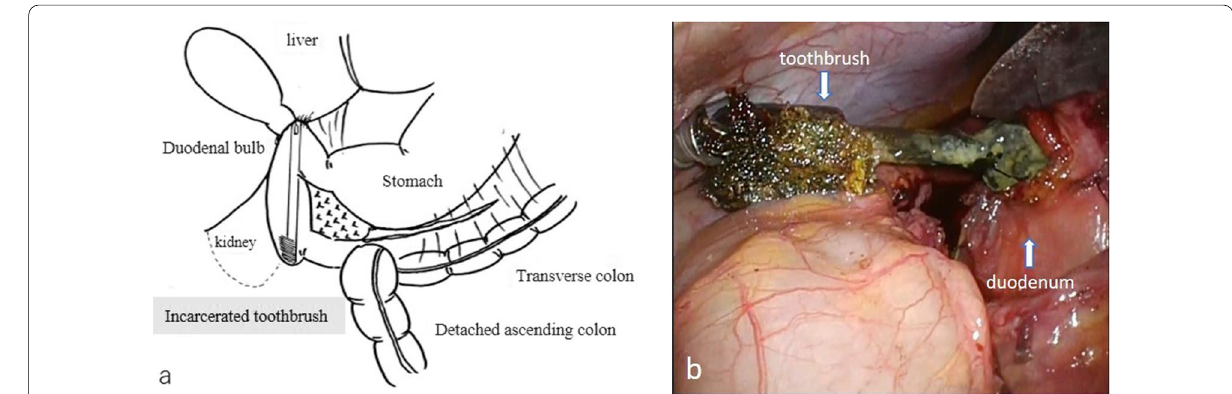
Fig. 3 a Schema of surgical findings and approach. b Intraoperative photograph. The toothbrush was removed through the incision made on the caudal side of the